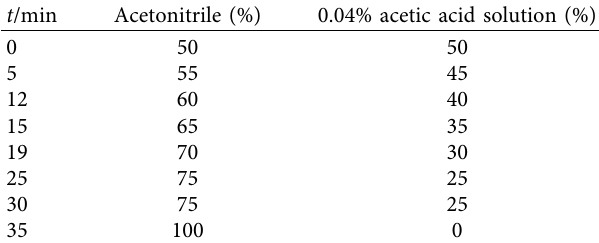
Table 1: LC time